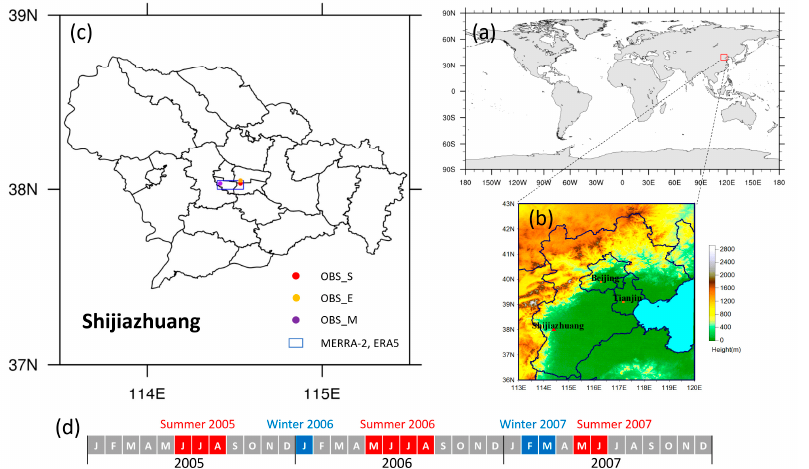
Figure 1. The location of the study area and the observed periods in this study. ( a ) The location of the Beijing-Tianjin-Hebei region (red box) in the world map; ( b ) the location of Shijiazhuang in the Beijing-Tianjin-Hebei region and its topographic map. ( c ) Sampling stations (colored points, OBS_S: Hebei Meteorological Service Station; OBS_E: Environmental Monitoring Center; OBS_M: Meteorological Observation Station), as well as the extraction area (blue box) for obtaining the reanalysis data; ( d ) the observed periods include summer 2005, winter 2006, summer 2006, winter 2007, and summer 2007 (detailed time is listed in Table